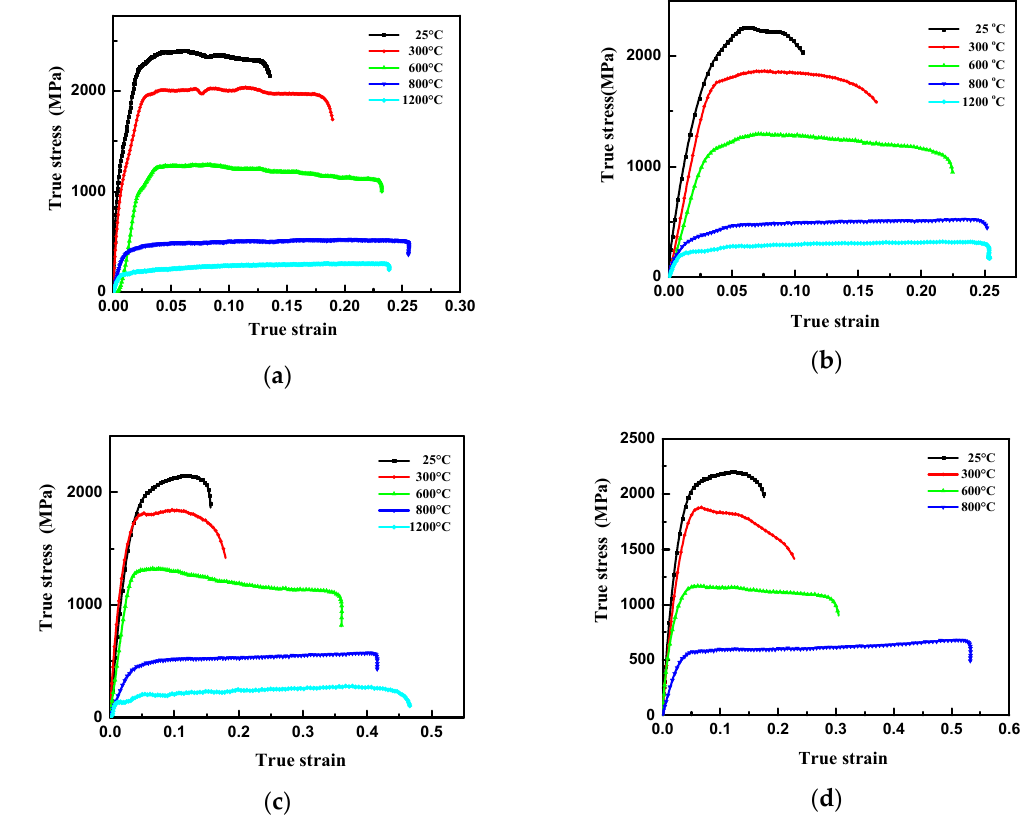
Figure 9. Stress–strain curves of iron–nickel based ultra-high strength steel at different strain rates ( a ) 1000 s − 1 ; ( b ) 4000 s − 1 ; ( c ) 7000 s − 1 ; and ( d ) 10,000 s − 1 .